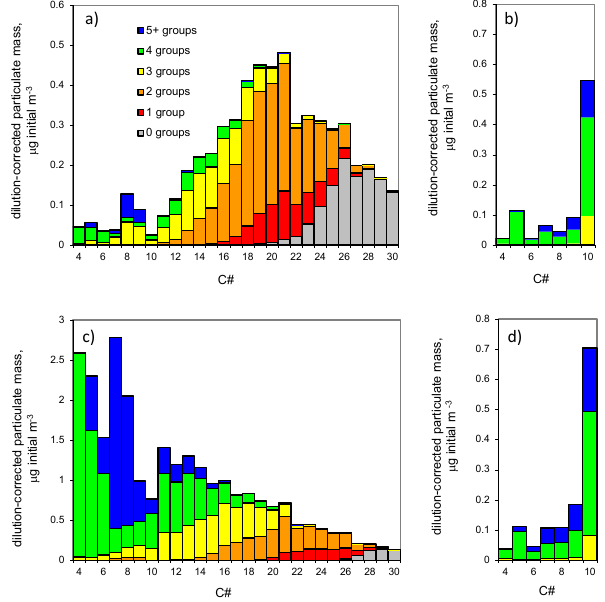
Figure 4. Particle mass composition binned by carbon number and number of functional groups per constituent molecule. (a) Urban case at start of outflow phase; (b) forest case at start of outflow phase; (c) urban case after 4 days; (d) forest case after 3 days.